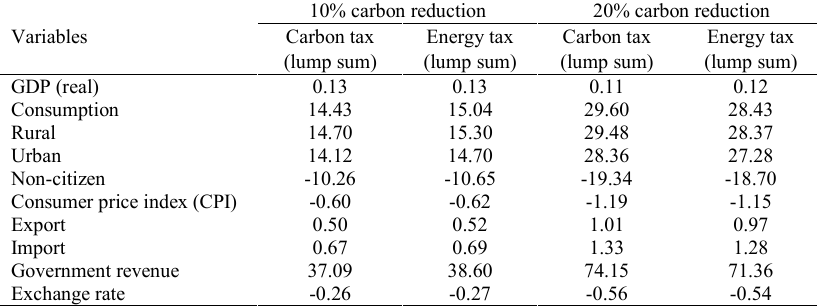
Note: similar results occurred for labor tax recycling